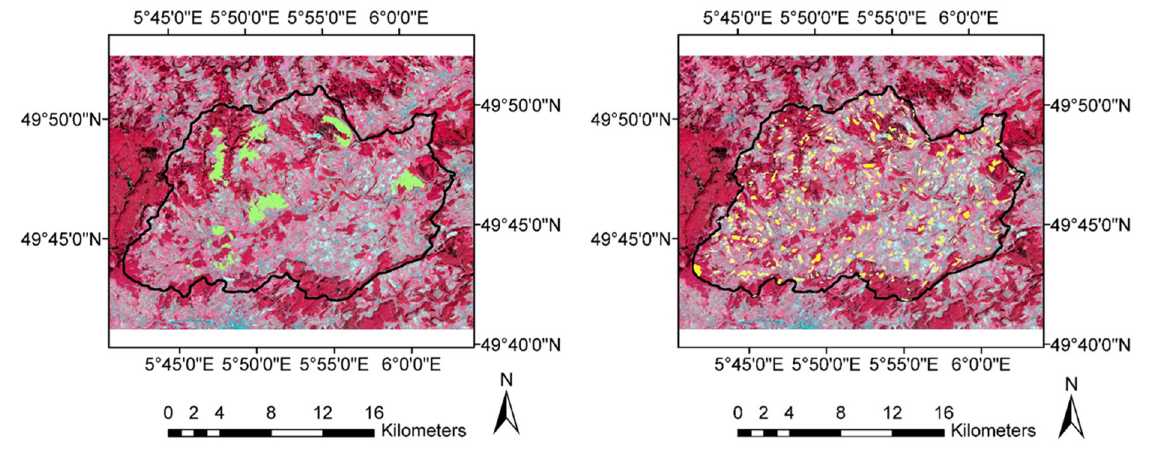
Figure 2. The agricultural ground truth area labelled in green during the field campaign in July 2013 ( left ) and all the training and validating pixels in yellow for the 7 classes of the Level 2 category based on the historical land cover maps of 2007 ( right ); the background image of Attert Catchment (outlined in black) is the composite Landsat 8 image of July 2013 in RGB combination of band 4, band 3 and band